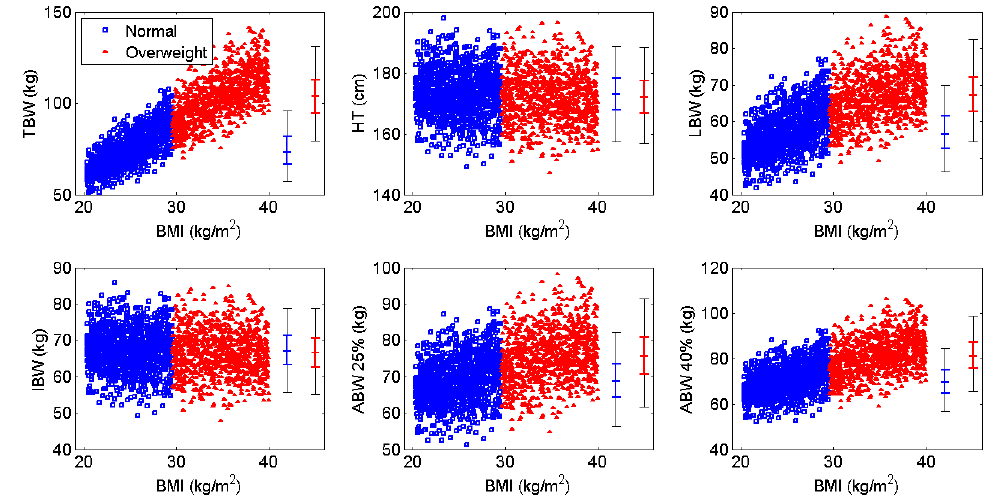
Figure 1. Correlation of body weight metrics with body mass index (BMI) for each BMI subgroup (blue = normal weight, red = overweight and obese). TBW: total body weight; HT: height; LBW: lean body weight; IBW: ideal body weight; ABW: adjusted body weight.